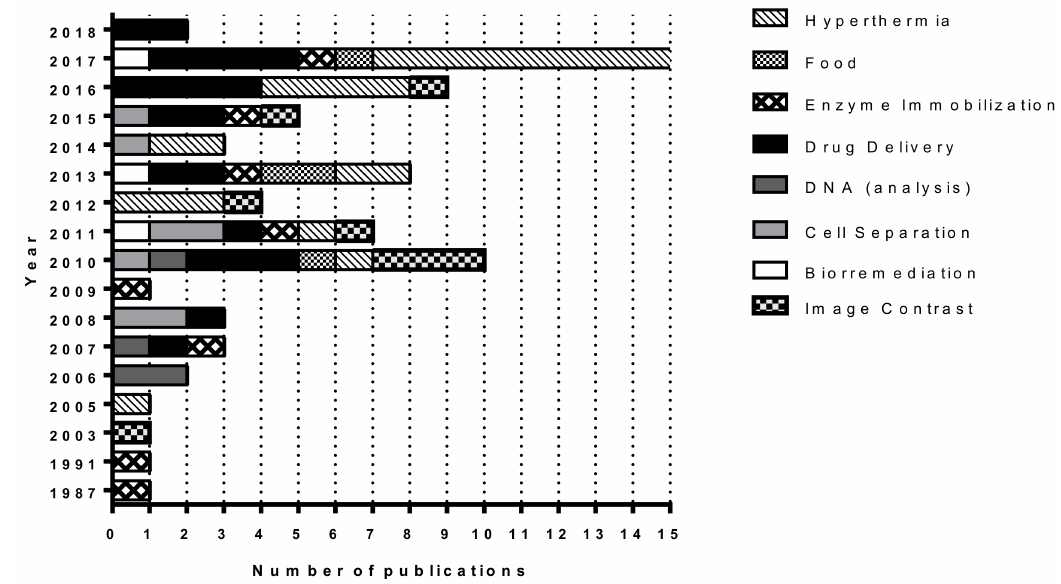
Figure 1. Classification of scientific publications reporting on applications of magnetosomes by area [7,8] from 1987 until 2018. Scientific articles containing the keyword “magnetosome (s)” in the title were classified in different subareas of Biotechnology (bioremediation, cell separation, DNA analysis, drug delivery, enzyme immobilization, food, hyperthermia, image contrast). For analysis of raw data, see Table S1. The criteria used for selection of these data are detailed in “Database generation & analysis